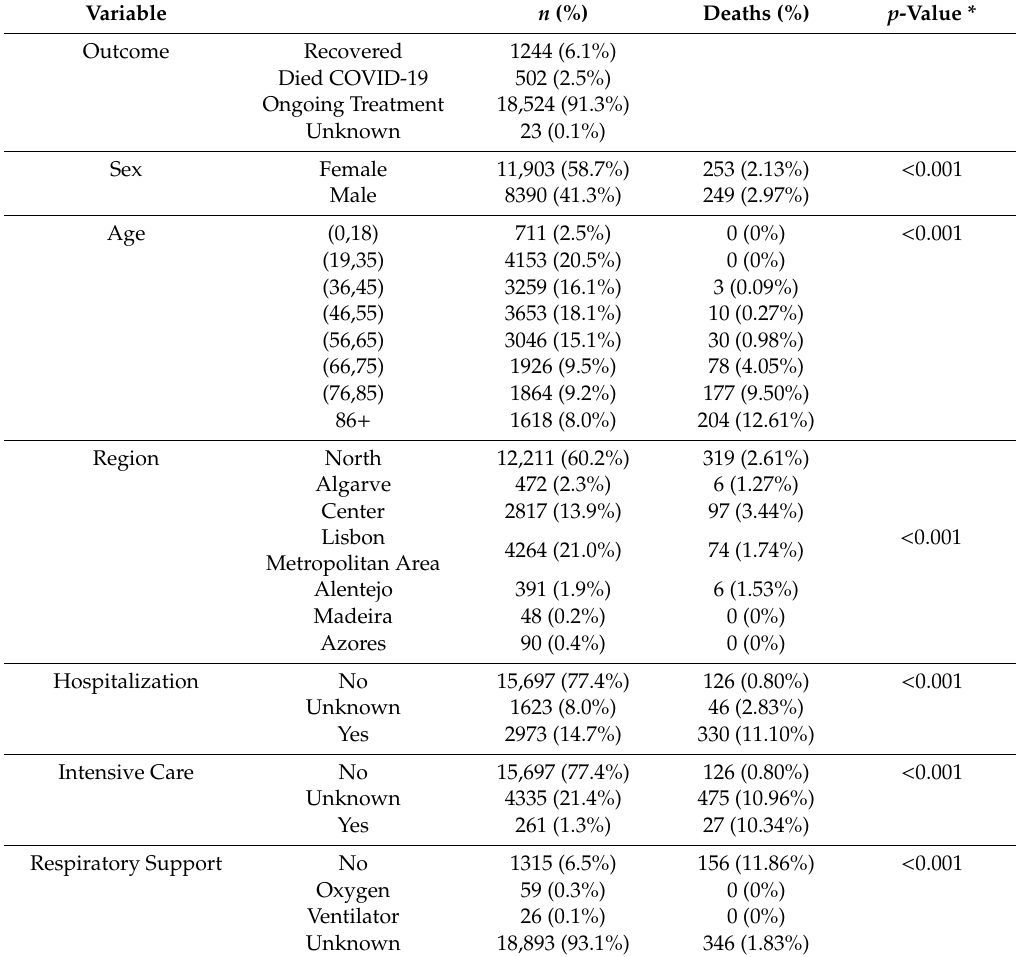
Table 1. Characteristics of the SARS-CoV-2 infected individuals and corresponding lethality in